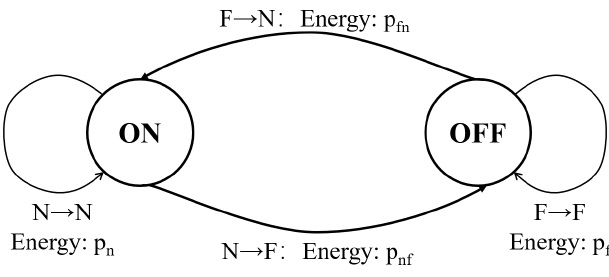
Figure 2. The finite state machine (FSM) of a sensor node’s